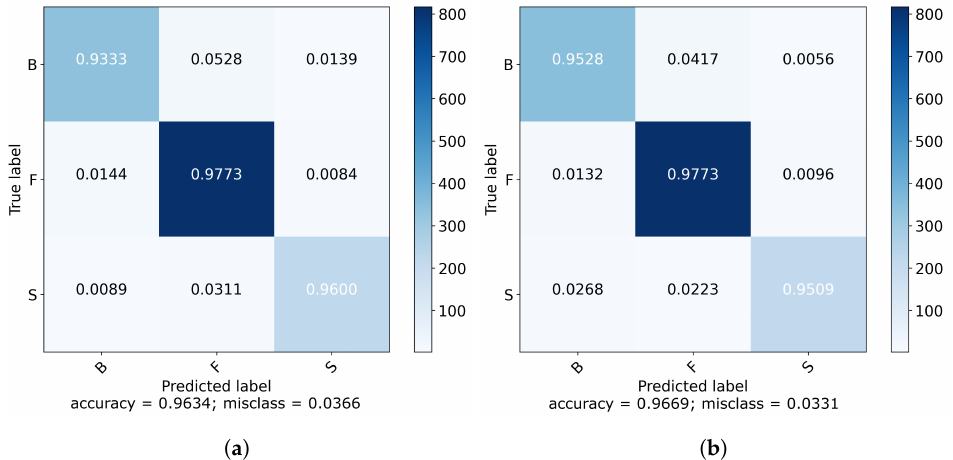
Figure 12. Normalized confusion matrix for the FCN ( a ) and the ResNet ( b ) comparing the three classes: backhand (B), forehand (F), and service